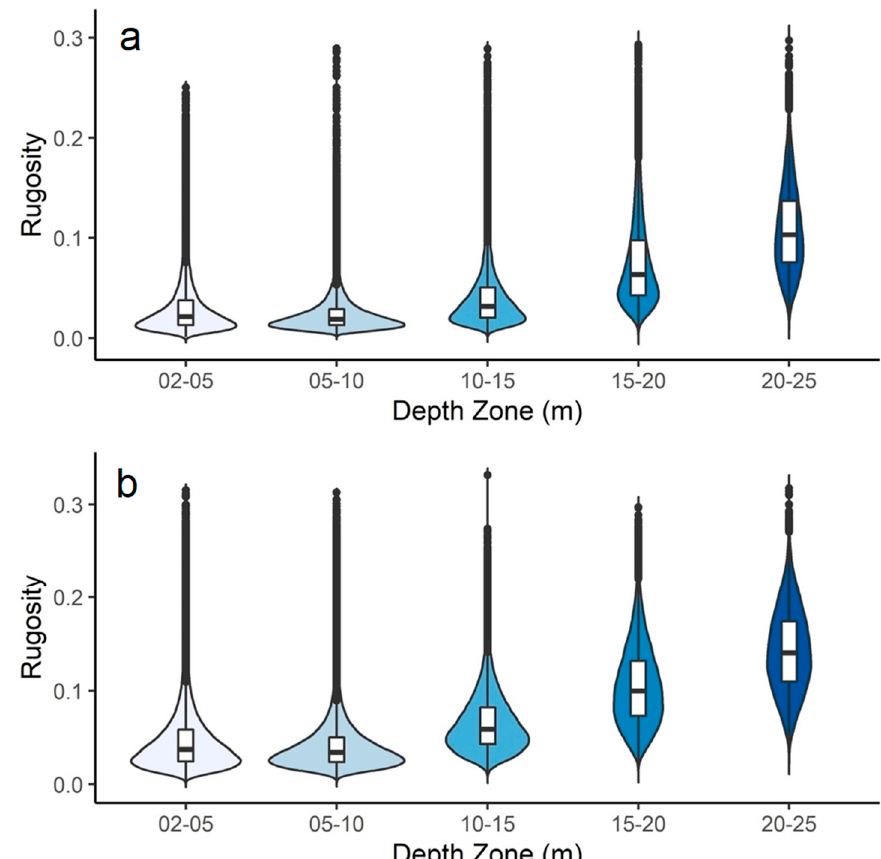
Figure 7. Violin plots of reef rugosity versus depth (m) for ( a ) P¯ap¯a Bay and ( b ) Honaunau Bay showing a general increase in rugosity with depth, matching observations of more complex coral habitat in deeper waters. Each plot shows the frequency distribution of high-resolution rugosity values using 40 cm and 65 cm spatial resolution bathymetry maps for P¯ap¯a and Honaunau Bays, respectively. Box plots within violin plots indicate the median, first quartile and third quartile of the distributions.